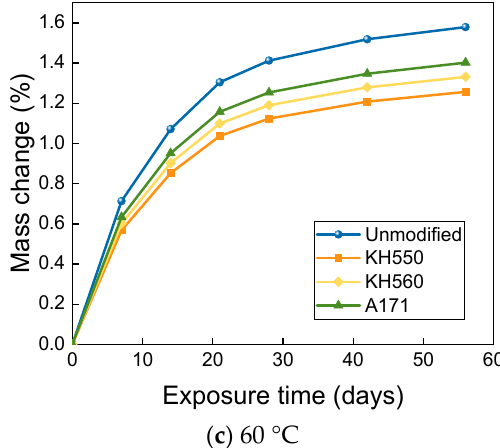
Figure 16. Mass change in a 10% NaOH alkaline